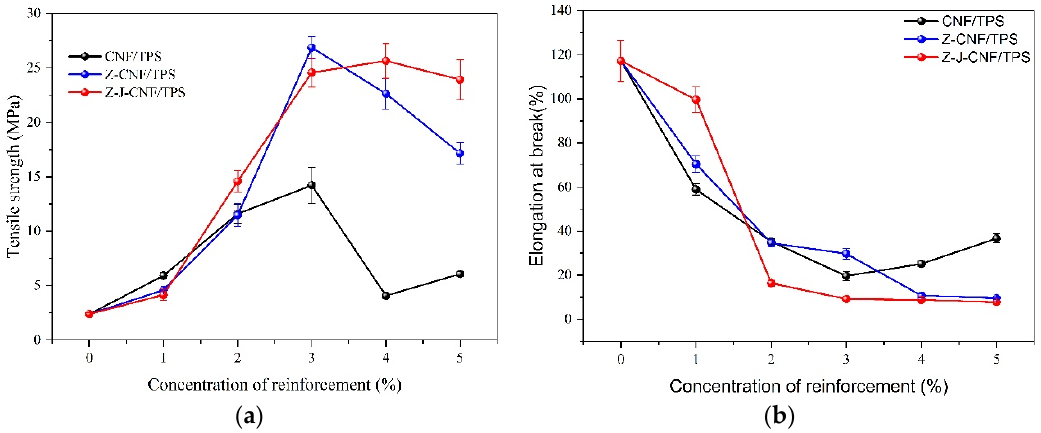
Figure 8. Effects of CNF, Z-CNF, and Z-J-CNF content of the composite films on: ( a ) the tensile strength; and ( b ) the elongation at break.